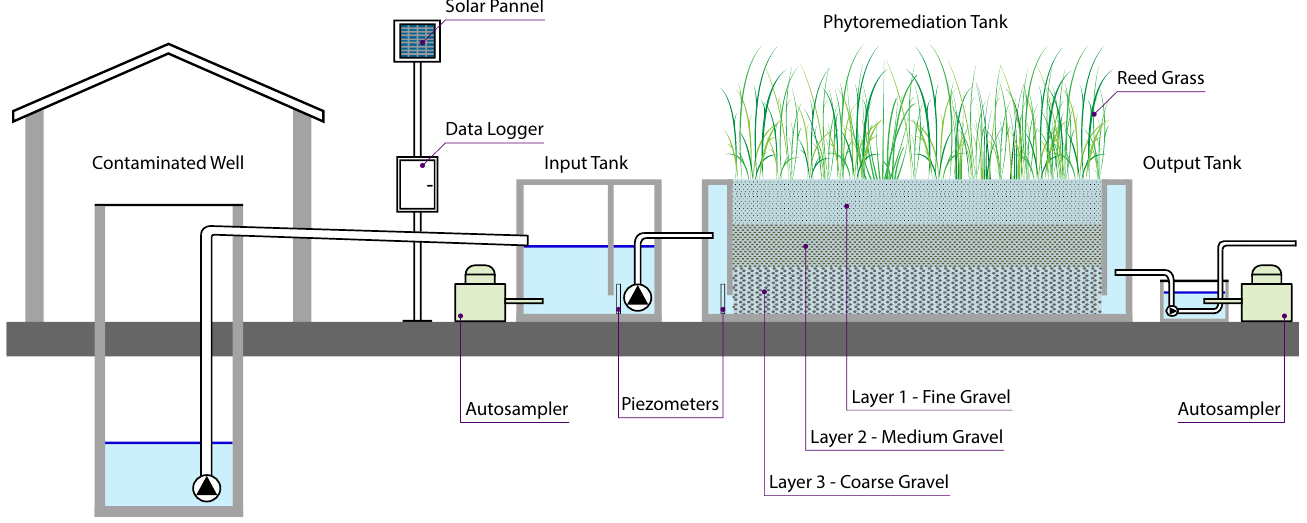
Figure 1. Overview of the Lonigo phytoremediation pilot plant (the dimensions are not in scale). The phytoremediation tank had a central section containing three layers of gravel with different granulometry over which the reed grasses were planted. Going from the top to the bottom, there was a thin layer of 5 cm of fine gravel (5 mm of diameter), below